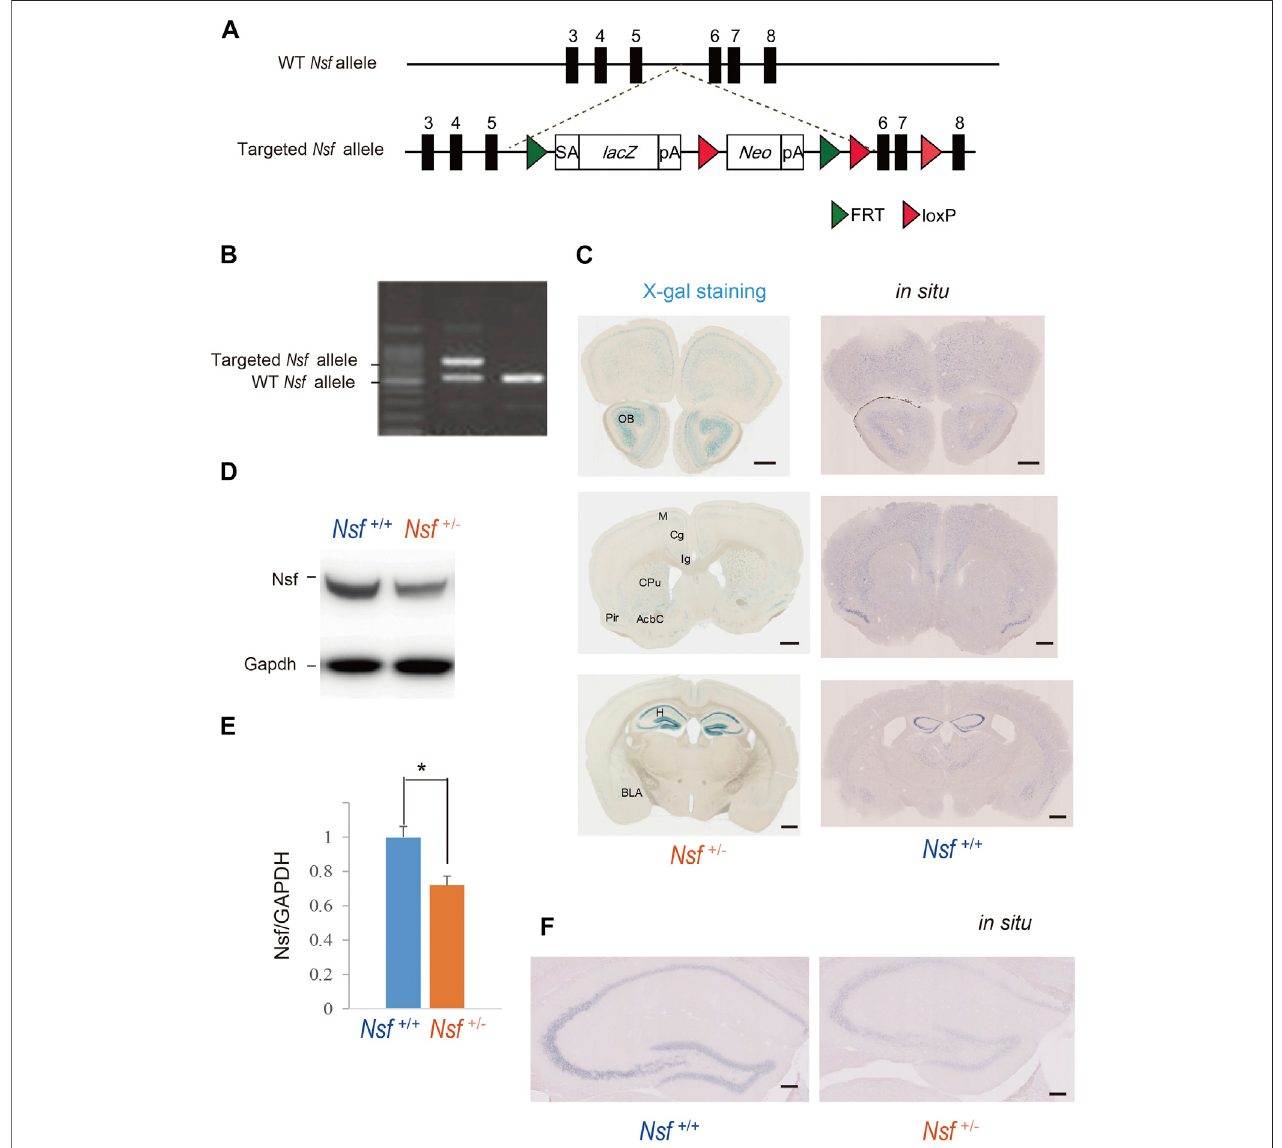
FIGURE 1 | Generation of Nsf knockout mice (A) Schematic representation of the genomic structure of the relevant part of the Nsf wild-type (WT) allele and the targetedalleleconstructwithspliceacceptor(SA)sequence, IRES followedby lacZ (fusionof β -galgeneandneomycinphosphotransferasegene),andapolyadenylation signalsequence(pA).Exons5and6of Nsf are fl ankedby lacZ andneomycinresistance( Neo )cassettes. (B) WTallelesandtargetedallelesweredetectedusinggenomic PCR.TheWTandmutantallelesareshownas504and737 bpfragments,respectively. (C) X-galstaining(leftpanels)and insitu hybridizationof Nsf (rightpanels)in Nsf +/ − mouse brains. H, hippocampus; M, motor cortex; Cg, cingulate cortex; Ig, indusium griseum; Cpu, caudate putamen; Pir, piriform cortex; Acb, accumbens nucleus; Bla,basolateralamygdala.Scalebarrepresents500 μ m. (D) Nsfproteinexpression inthehippocampus from Nsf +/+ and Nsf +/ − mice wasdetected bywestern blotting(upperpanel).Theblotsweresubsequentlyprobedwithananti-Gapdhantibodyasaproteinloadingcontrol(lowerpanel). (E) RelativebanddensitiesofNsfwere quanti fi ed using scanning densitometry ( n (cid:1) 4 for each genotype; mean ± SEM. Student ’ s t -test, * p < 0.05). (F) In situ hybridization of Nsf in the hippocampus of Nsf +/+ mice (right panel) and Nsf +/ − mice (left panel). Scale bar represents 2.5